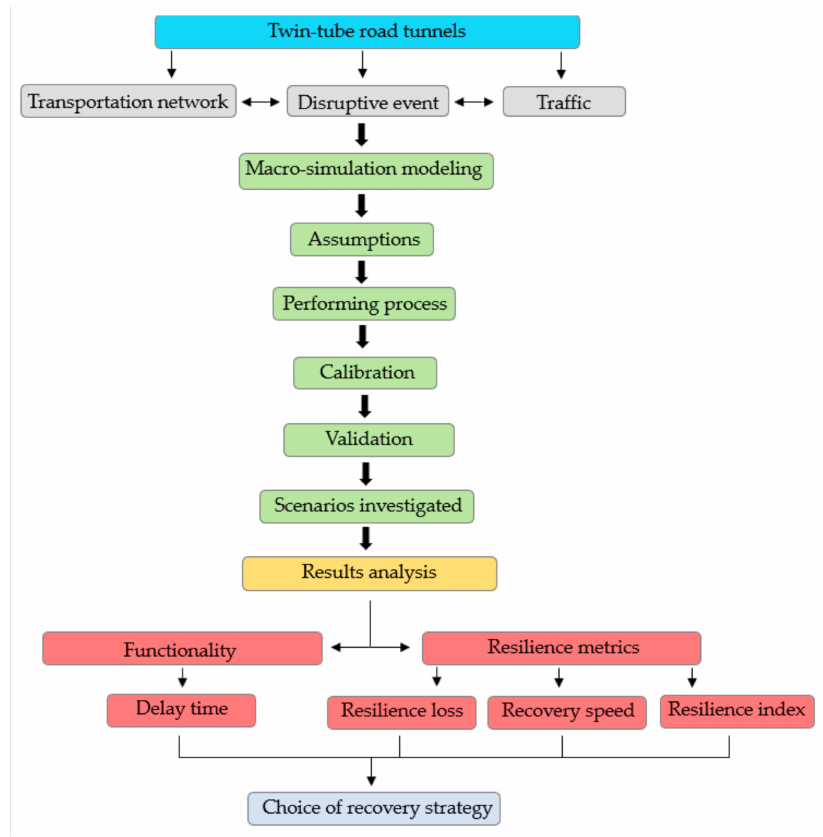
Figure 5. Flow chart of the